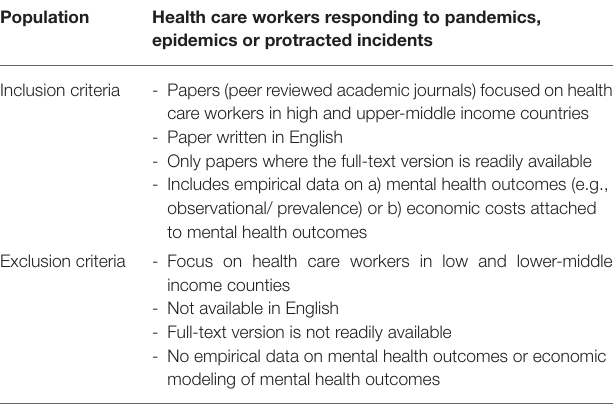
TABLE 1 | Inclusion and exclusion criteria used for the rapid evidence assessment.